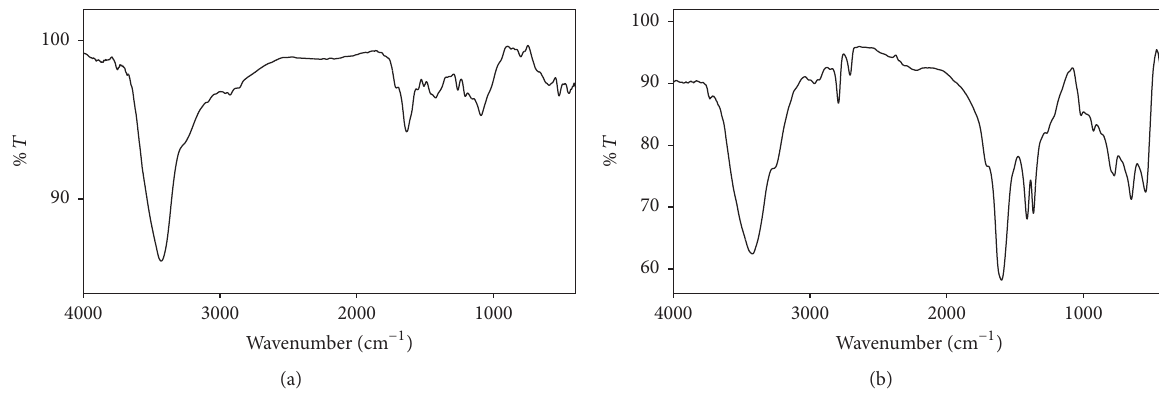
Figure 1: FTIR spectra of (a) chitosan (CS) and (b) CS/3-phenyl-1H-pyrazole-4-carbaldehyde.